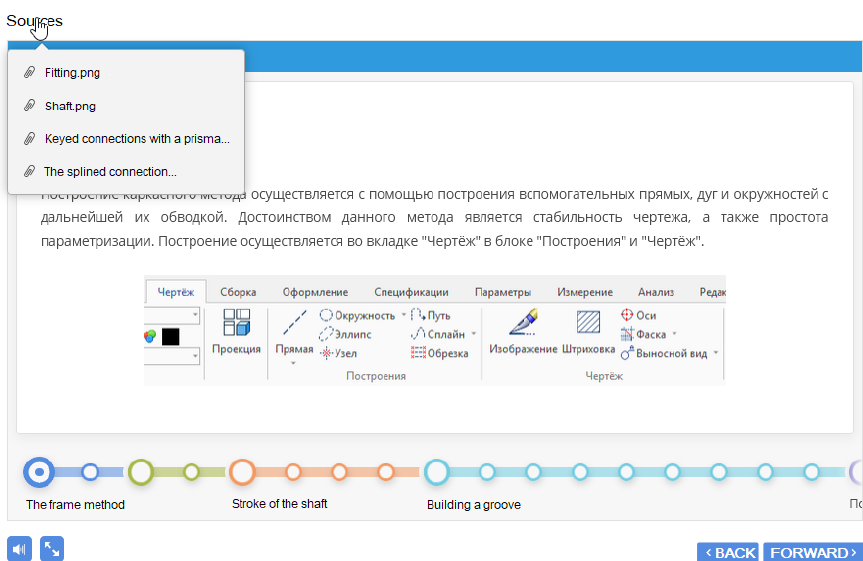
Fig. 7. Location of resources in